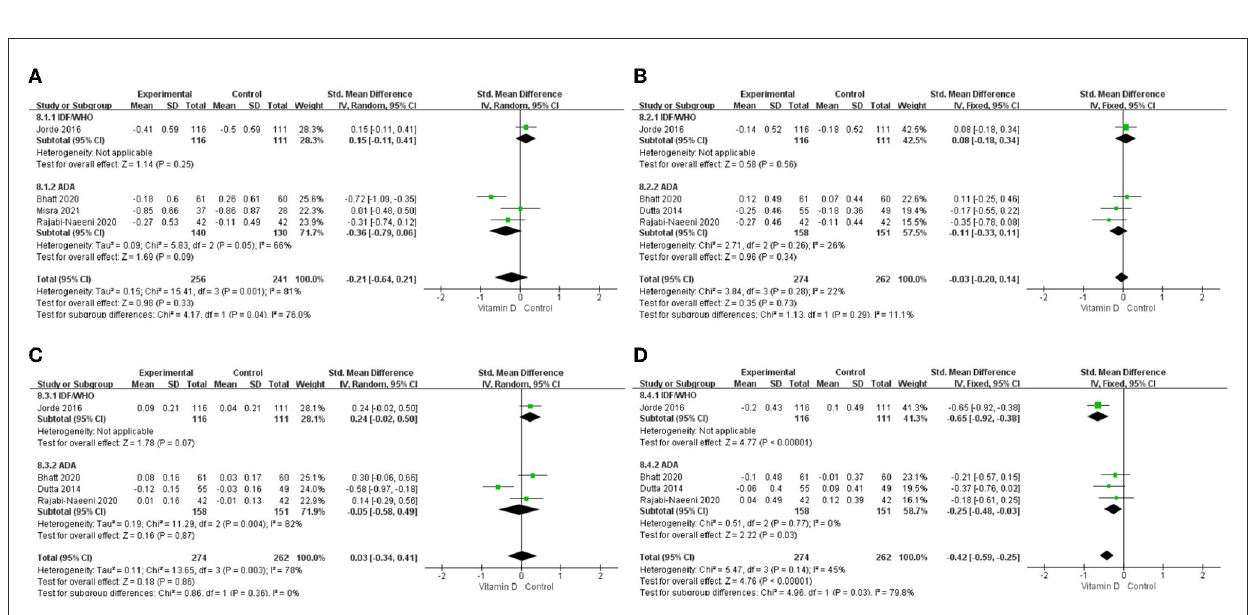
FIGURE9 Subgroup analysis by criteria for prediabetes definition. (A) TC, (B) LDL-C, (C) HDL-C, and (D) TG. TC, total cholesterol; LDL-C, low-density lipoprotein cholesterol; HDL-C, high-density lipoprotein cholesterol; TG, triglyceride; IDF, International Diabetes Federation; ADA, American Diabetes Association; WHO, World Health Organization; Criteria of IDF/ WHO from 2006: fasting plasma glucose value in the range of 6.1–6.9 mmol/L or 110–125 mg/dl, or 2h oral glucose tolerance test (OGTT) plasma glucose value in the range of 7.8–11.0 mmol/L or 140–200 mg/dl; Criteria of ADA from 2004: fasting plasma glucose value in the range of 5.6–6.9 mmol/L or 100–125 mg/dl, or 2h OGTT plasma glucose value in the range of 7.8–11.0 mmol/L or 140–200 mg/dl; or HbA1c in the range of 39–47 mmol/mol or